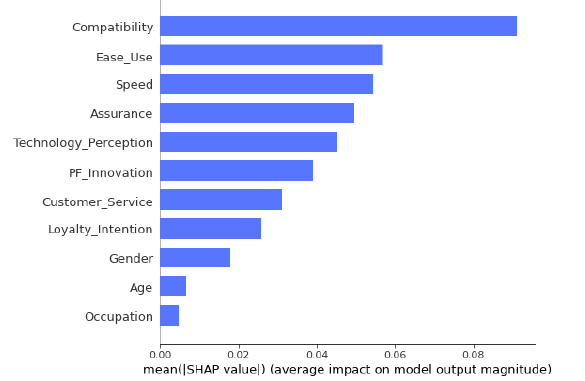
Figure 6. SHAP—Interpretation with